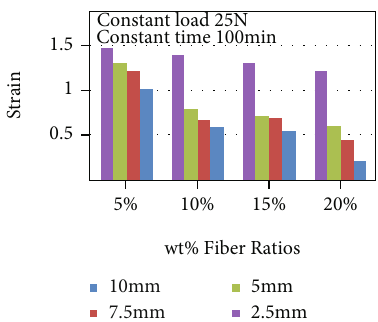
Figure 8: Strain values of RP-DPF composites for di ff erent lengths with di ff erent weight ratios and strain times and constant applied load of 25 N for 100min strain time.